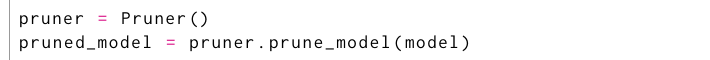
Listing 9. Code required to prune a filter-sparse